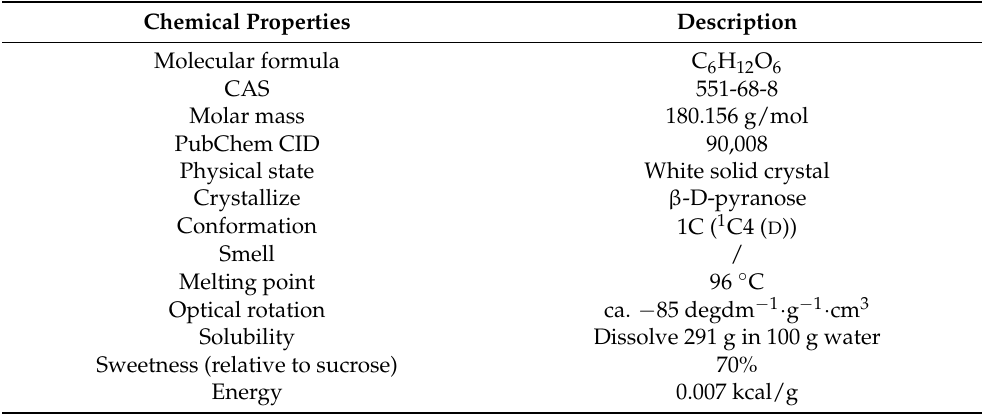
Table 1. Detailed chemical properties of D